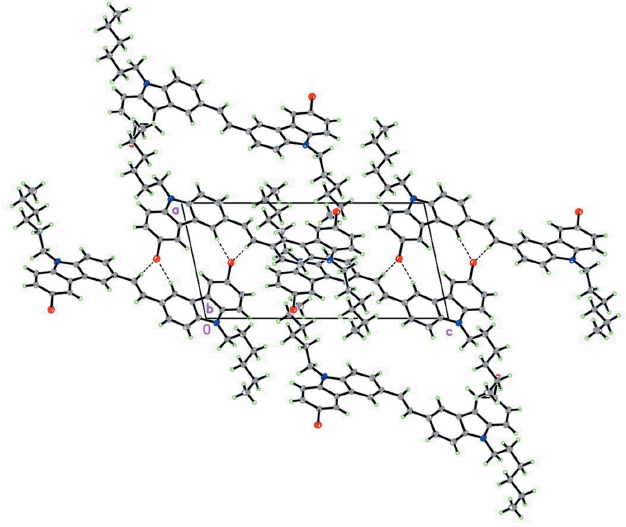
Figure 2 The crystal packing of the title compound 1 viewed along the b axis.